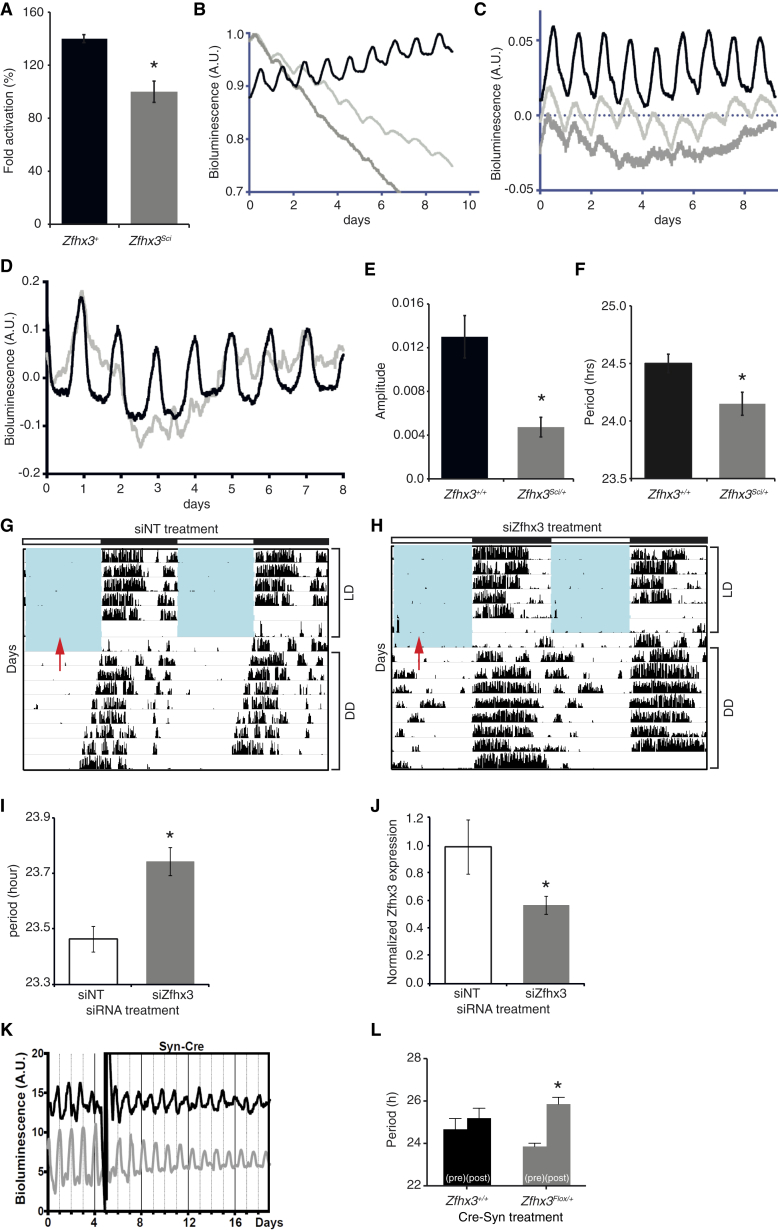
ZFHX3SCI Differentially Activates a Circadian Motif in SCN(A) In vitro activation of the AT motif by overexpressing Zfhx3 without and with the Sci mutation (Zfhx3+ and Zfhx3Sci respectively) using a luciferase reporter construct driven by the AT motif (×7) in HEK293 cells. Zfhx3+ transcriptionally activated the AT motif, while Zfhx3Sci did not (p < 0.05, t test).(B and C) As shown, (B) raw data and (C) de-trended data show circadian activation of AT sequences in SCN slices transduced by LVs coding for the luciferase reporter driven by the AT motif. A.U., arbitrary units.(D) AT-motif-driven luciferase expression in SCN slices from Zfhx3Sci/+ (gray lines) and Zfhx3+/+ (black lines) mice.(E and F) There was a substantial decrease in (E) the amplitude of AT motif activation in Zfhx3Sci/+ and a small, but significant decrease in (F) period compared to Zfhx3+/+ (p < 0.05, t test).(G and H) Representative double-plotted actograms of wheel-running activity in C57Bl/6 mice injected with (G) control siRNA (siNT) or (H) siZfhx3 (arrow denotes time of injection). Blue shading represents periods when lights are on. Vertical black bars represent wheel running activity. LD, light:dark cycle.(I) Animals injected with siZfhx3 had a significantly lengthened τDD (23.74 ± 0.05 hr, mean ± SEM) compared to control siRNA (23.46 ± 0.05 hr). p < 0.05, t test.(J) Injection of siZfhx3 led to a 43% downregulation of Zfhx3 mRNA levels compared to control siRNA (p < 0.05, t test).(K and L) In (K), representative plots are shown of AT activation before and after transduction with the Syn-CRE vector in ex vivo SCN of Zfhx3+/+ (black lines) and Zfhx3Flox/+ mice (gray lines). (L) Zfhx3 deletion in Zfhx3Flox/+ SCN significantly lengthened the period of AT activation relative to Zfhx3+/+.Error bars indicate SEM. ∗p < 0.05, t test.See also Figure S4.